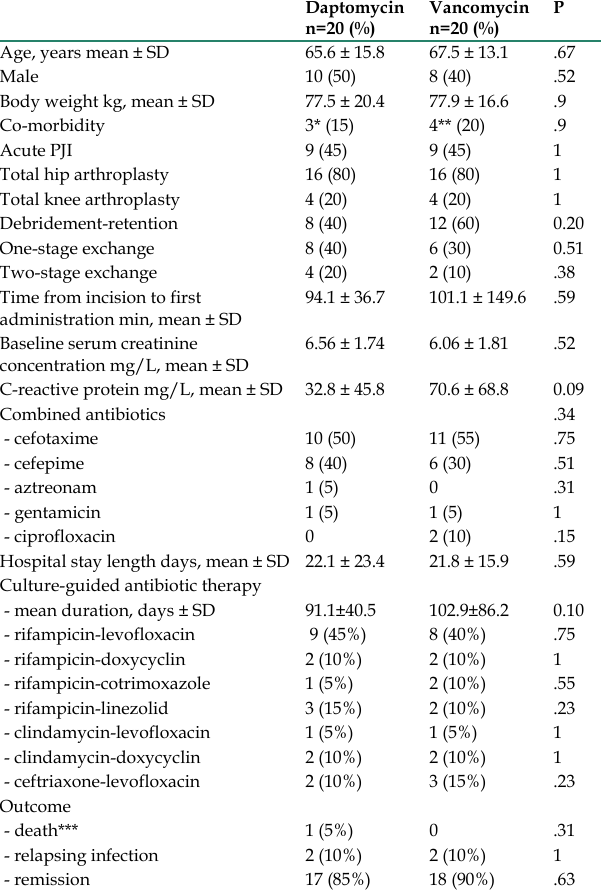
Table 1. Compared characteristics and outcome of 40 patients treated empirically with either Vancomycin or Daptomycin for a periprosthetic joint infection